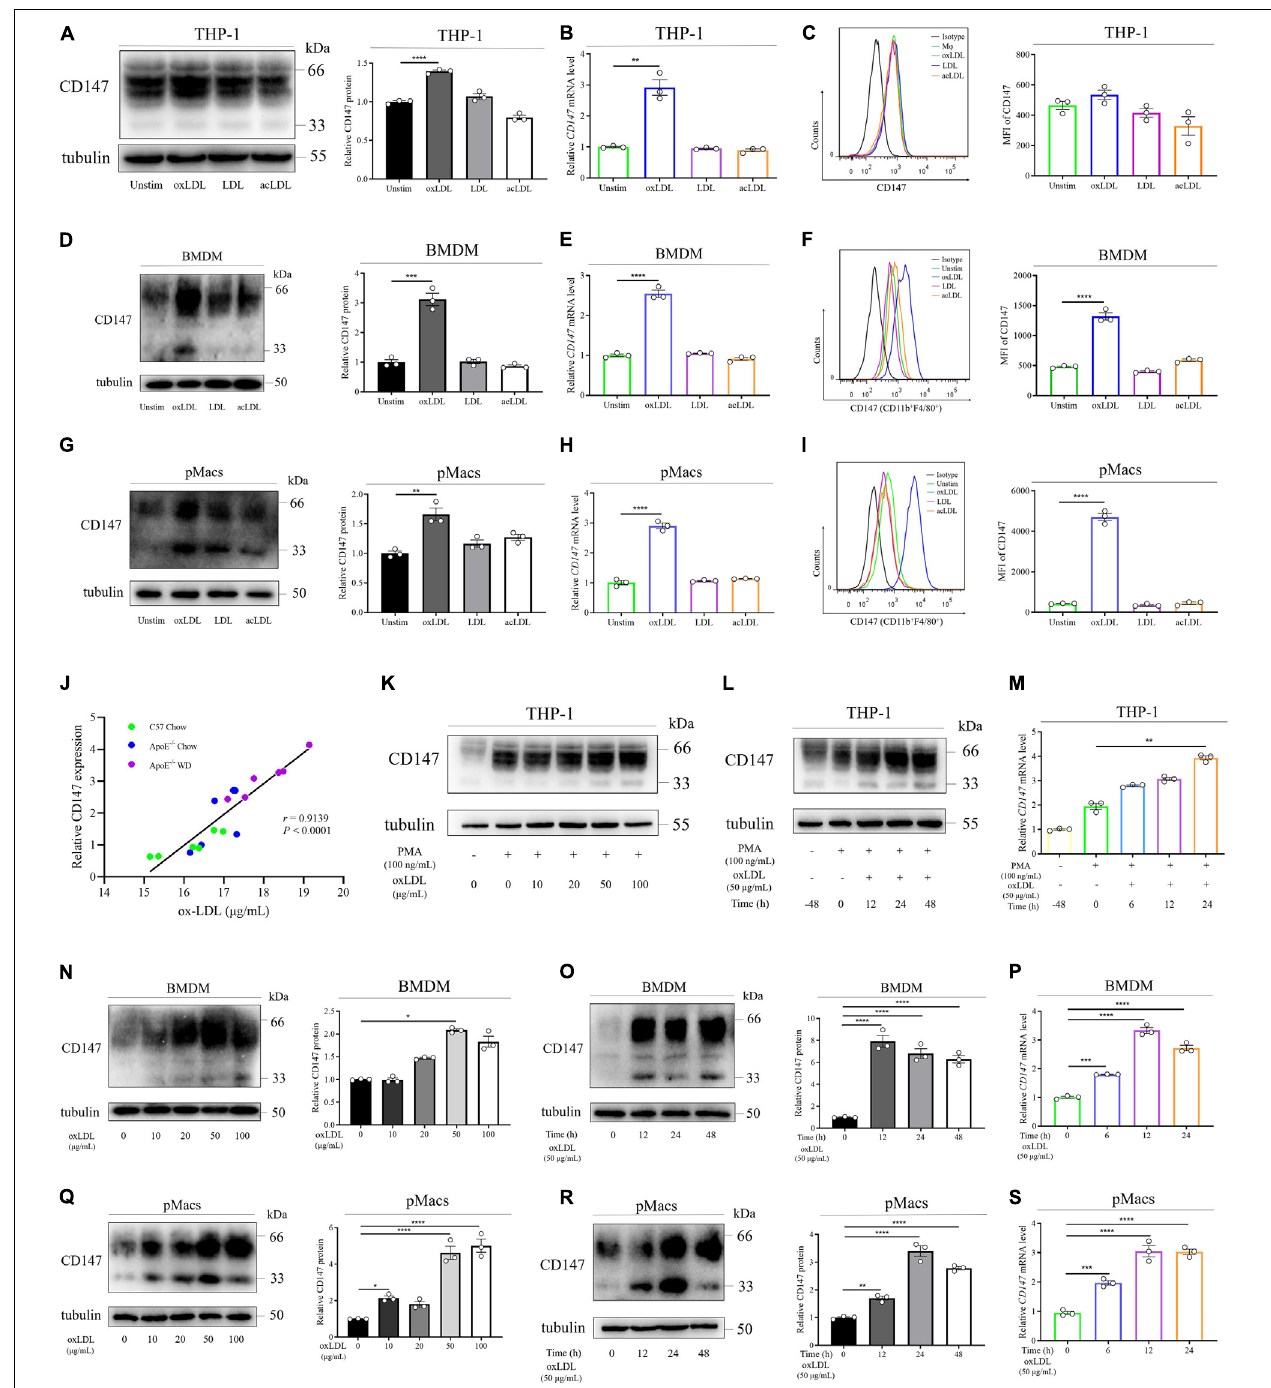
FIGURE 2 | Macrophage CD147 is upregulated by ox-LDL. (A–I) CD147 expression was assessed by western blotting (A,D,G) , RT-PCR (B,E,H) , or flow cytometry (C,F,I) in THP-1-induced macrophages (A–C) and CD11b + F4/80 + BMDMs (D–F) and pMacs (G–I) incubated with ox-LDL, LDL, or ac-LDL (50 µ g/mL) for 24 h. Right panel in (A,D,G) : CD147 expression is presented relative to that of tubulin (right). Right panel in (C,F,I) : quantification of the MFI of CD147 in each group. (J) The relative expression of CD147 by IHC was positively correlated with the serum level of ox-LDL ( r = 0.9139, P < 0.0001). (K–S) Western blot analysis of CD147 protein levels in THP-1-induced macrophages (K) , BMDMs (N) , and pMacs (Q) treated with different doses of ox-LDL for 24 h. RT-PCR analysis of CD147 mRNA levels in THP-1-induced macrophages (L) , BMDMs (O) , and pMacs (R) exposed to 50 µ g/mL ox-LDL for the indicated time. Flow cytometry in THP-1-induced macrophages (M) , BMDMs (P) , and pMacs (S) after treatment of 50 µ g/mL ox-LDL for the indicated time. Data represent the mean ± SEM. of n = 3 biologically independent experiments. * P < 0.05, ** P < 0.01, *** P < 0.001, **** P < 0.0001.